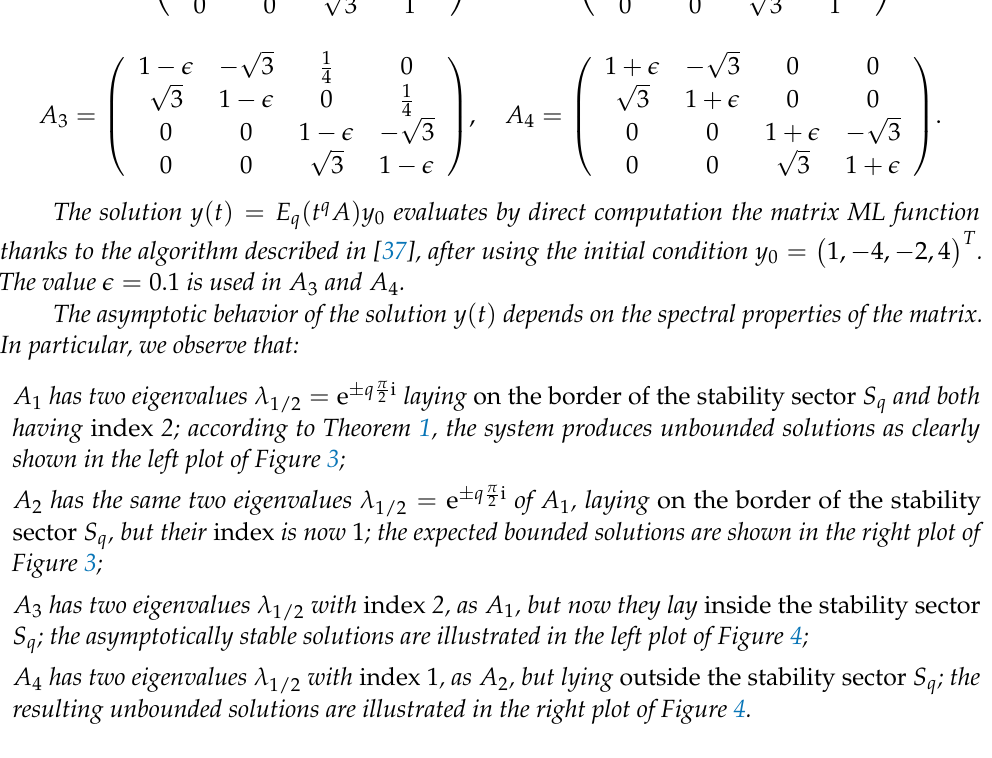
1 ( left plot) and